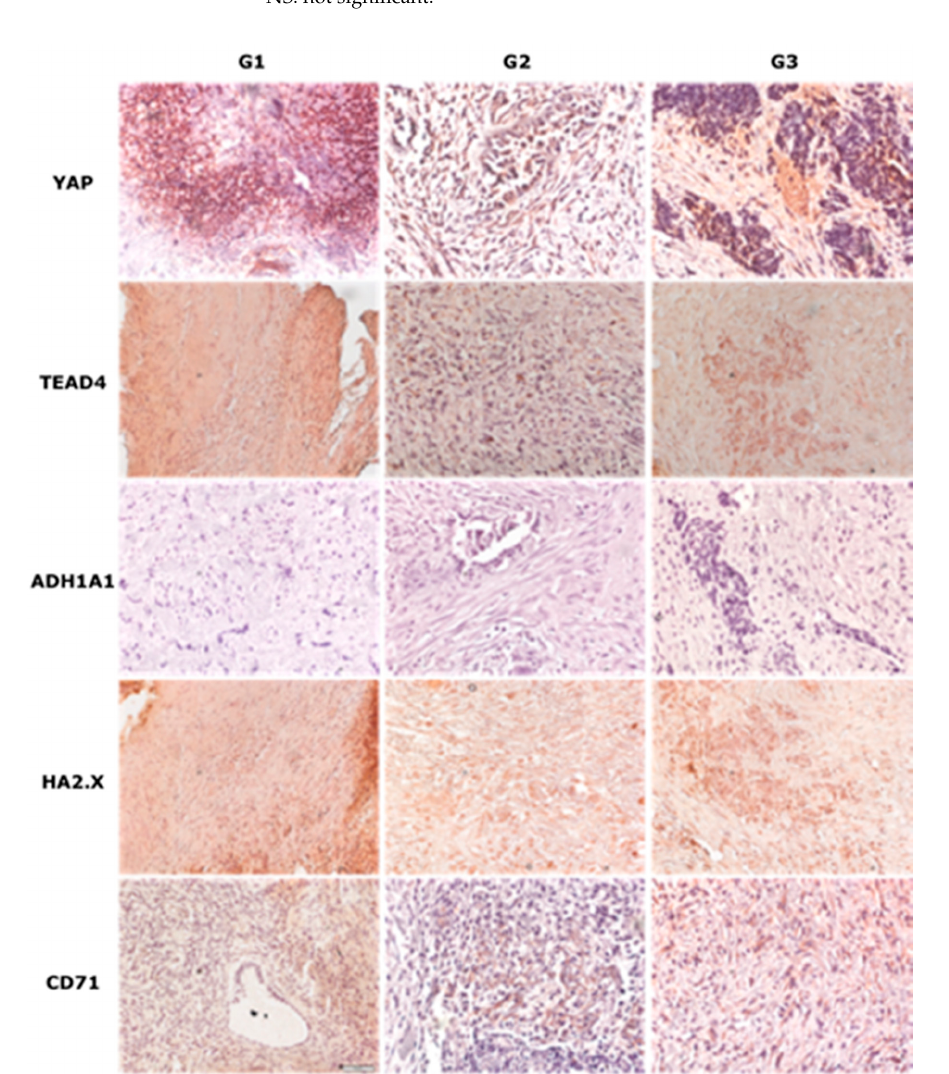
Figure 3. Immunohistochemical examination of YAP, TEAD4, ALDH1A1, HA2.X, and CD71 on specimens in different stages of disease (G1–G3). Magnification: 20 × , scale bar 50 µ